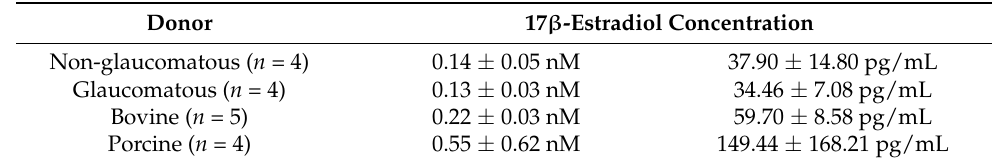
Table 9. 17 β -Estradiol Concentration in Bovine, Porcine, and Human Aqueous Humor. Donor 17 β -Estradiol Concentration